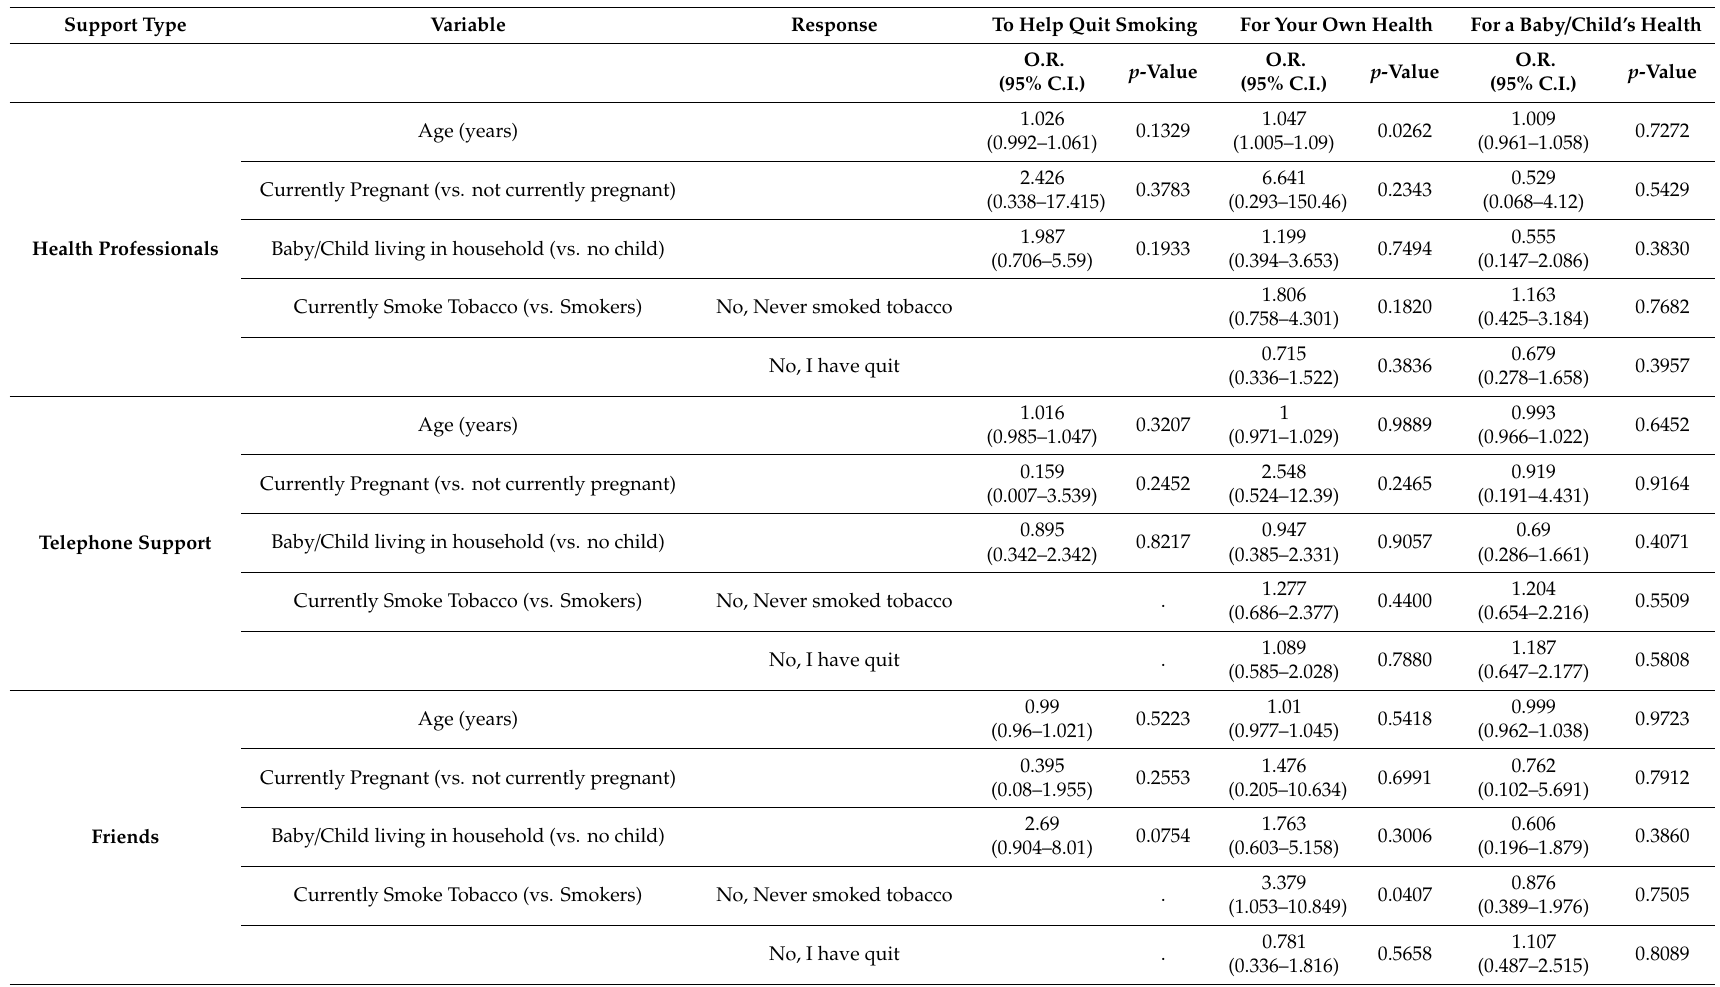
Table 3. Regression models for likelihood of accessing various sources of